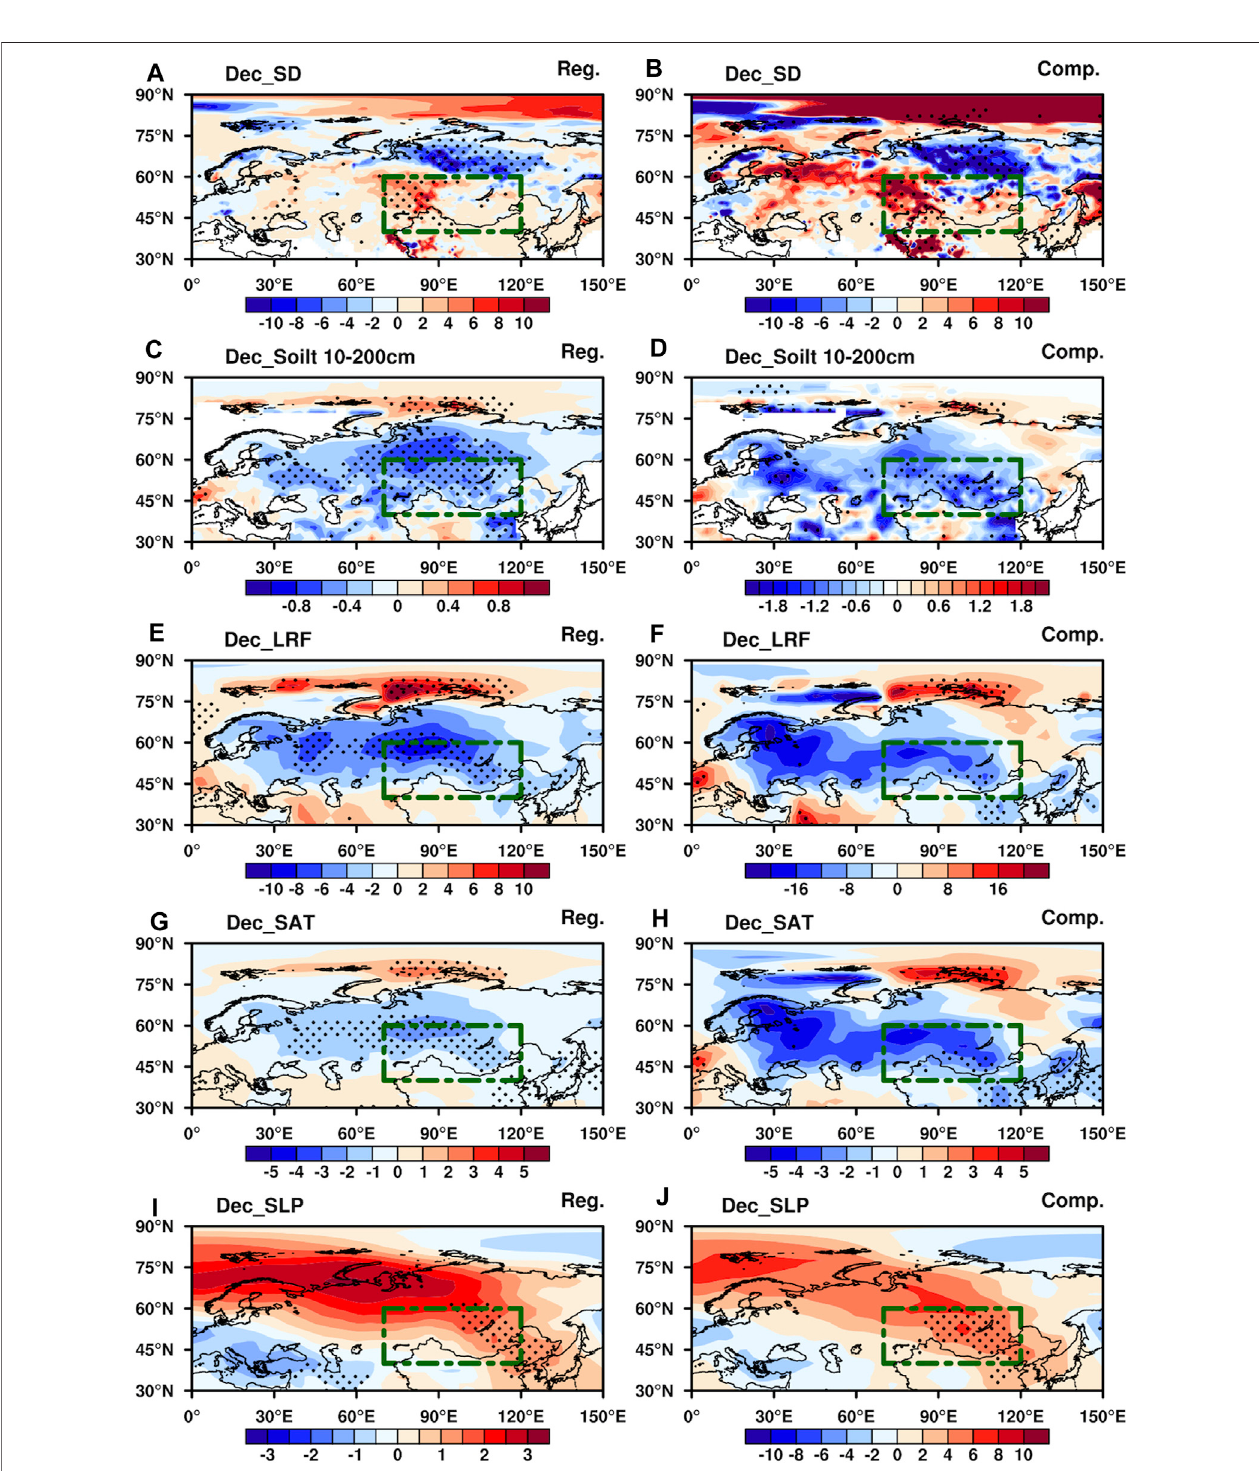
FIGURE 4 | (A, C, E, G, I) Regression of variables in December on the November SSDI and (B, D, F, H, J) results of composite differences in variables in December between SSD H – SHI + − and SSD L – SHI − + in December during 2000 – 2018: (A, B) SD (units: mm); (C, D) 10-200 cm soil temperature (units: K); (E, F) upward long-wave radiation fl ux (units: W m − 2 ); (G, H) SAT (units: ° C); (I, J) SLP (units: hPa). Dotted regions are statistically signi fi cant at the 90% con fi dence level, based on the t -test. The green dotted rectangle represents the key area of the SH (40 ° – 60 ° N, 70 ° – 120 ° E).